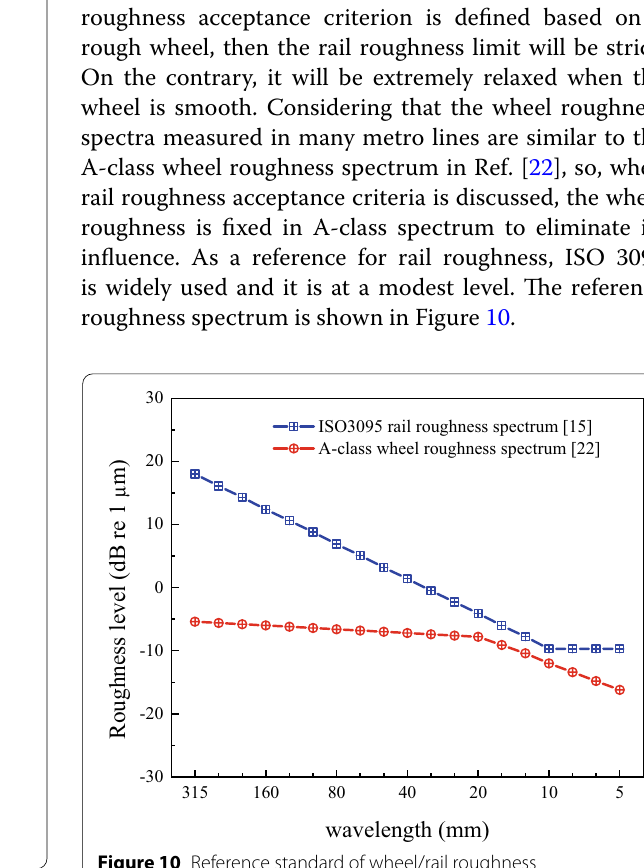
Figure 10 Reference standard of wheel/rail